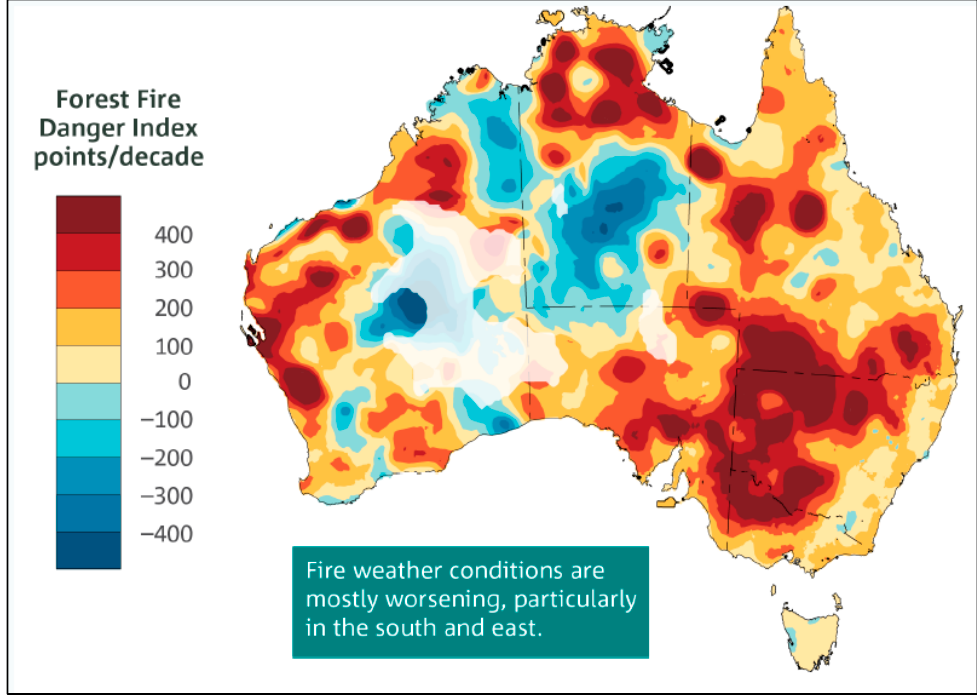
Figure 1. Trend in the annual sum of Forest Fire Danger Index, 1978–2017 [61].